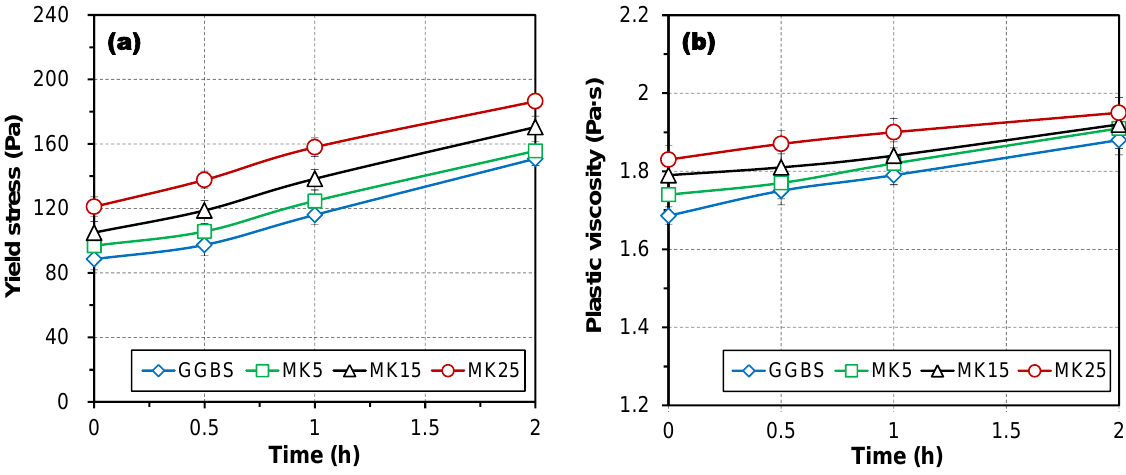
Figure 6. Evolution of MK- containing slurries’ yield stress ( a ) and viscosity ( b ) over time.